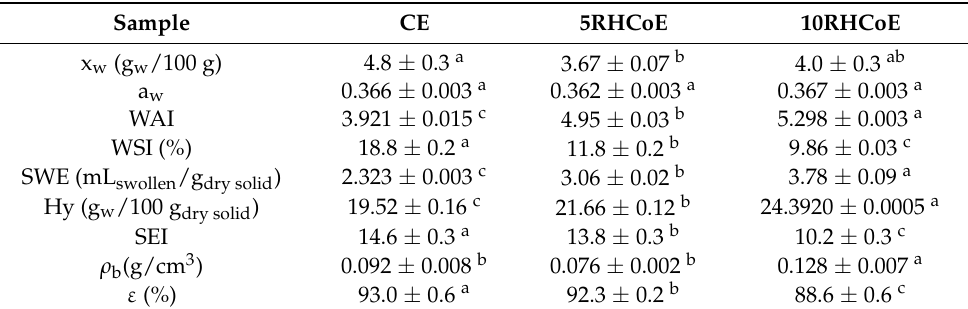
Table 2. Water content (x w ), water activity (a w ), water absorption index (WAI), water solubility index (WSI), swelling index (SWE), hygroscopicity (Hy), expansion index (SEI), bulk density ( ρ b ) and porosity ( ε ) of extrudates. Mean values ± standard deviations. Sample